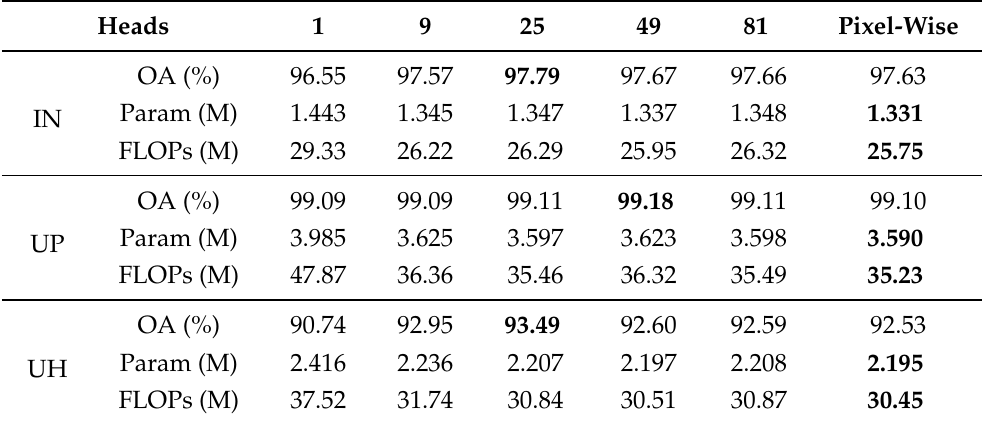
Table 3. Ablation study with different numbers of channel grouping and corresponding spatial attention heads. The best results are highlighted in bold font.